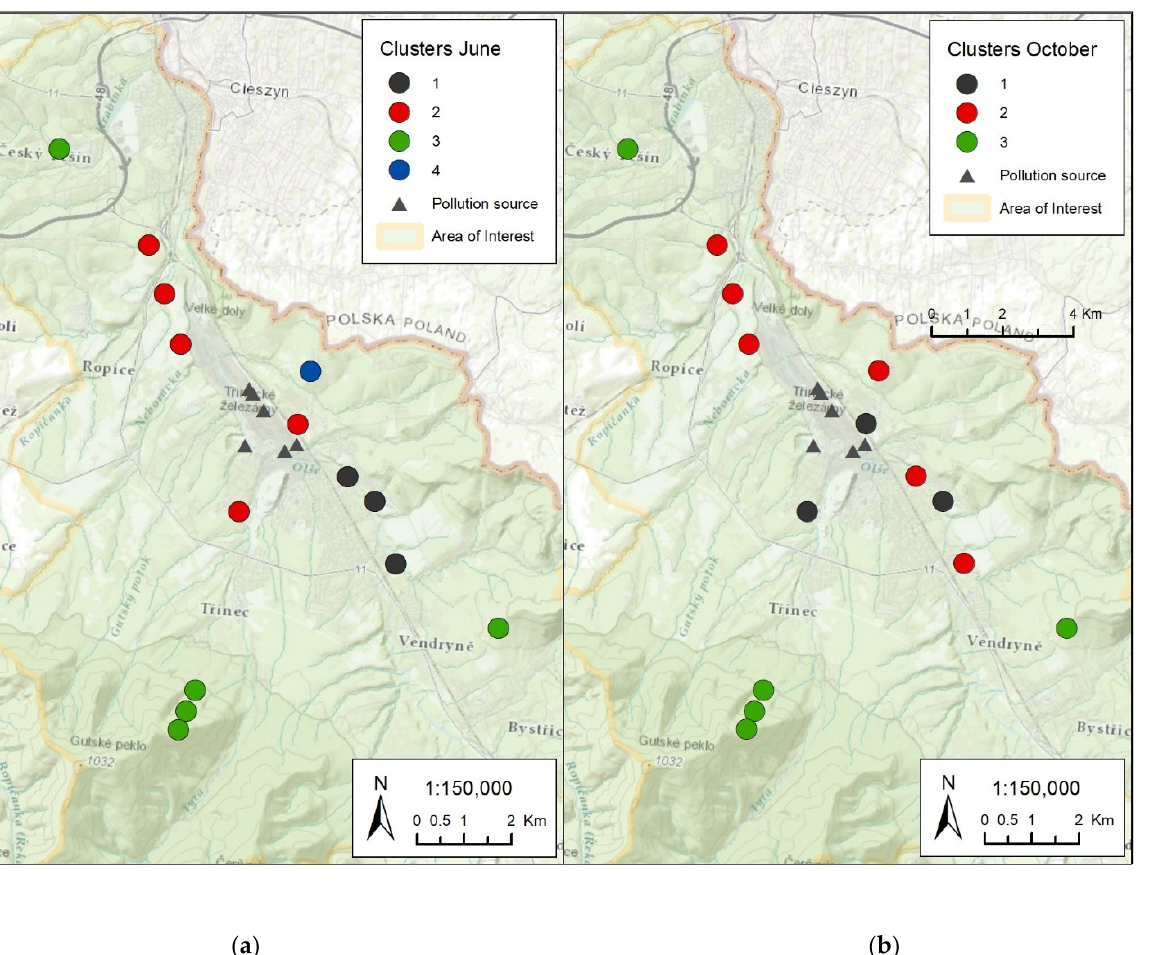
Figure 10. Clusters resulting from HCPC: ( a ) June sampling, ( b ) October sampling .